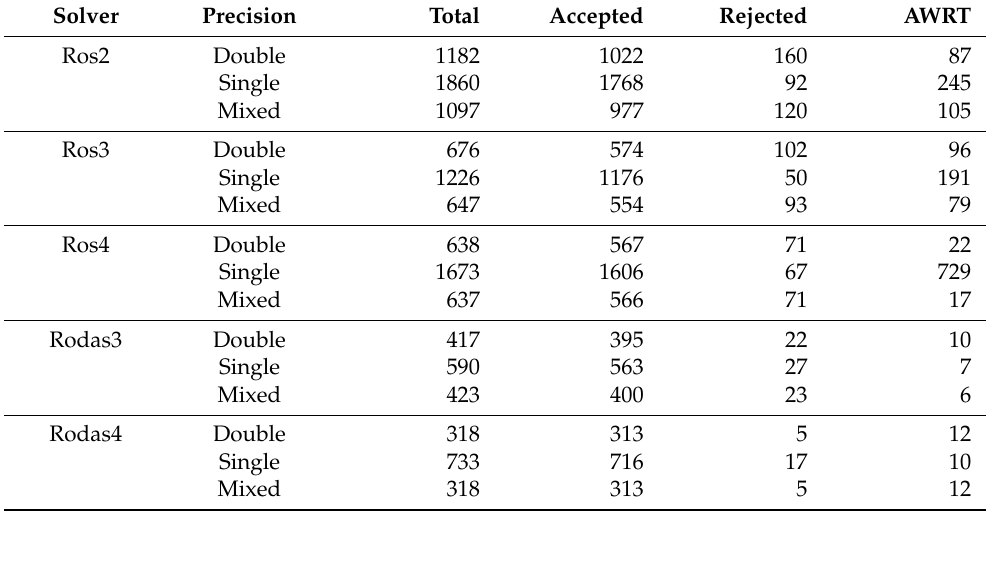
Table 2. Cumulative integration sub-steps with small mechanism at RelTol = 10 − 2 .